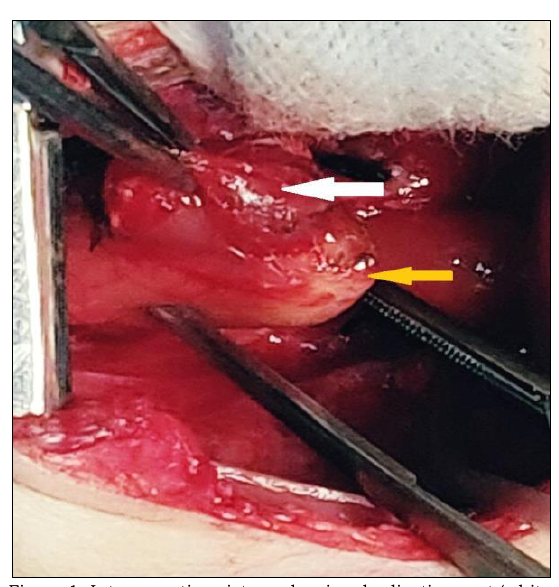
Figure 1: Intraoperative picture showing duplication cyst (white arrow) at the distal end of the upper pouch (yellow arrow) Histopathology confirmed an oesophageal duplication cyst with a lining of squamous epithelium and a two- layered arrangement of smooth muscle bundles (Fig 2). The postoperative recovery was uneventful, with a normal oesophagogram study on day 5 and the child was discharged on the tenth day. The child is well at follow-up of 4.5